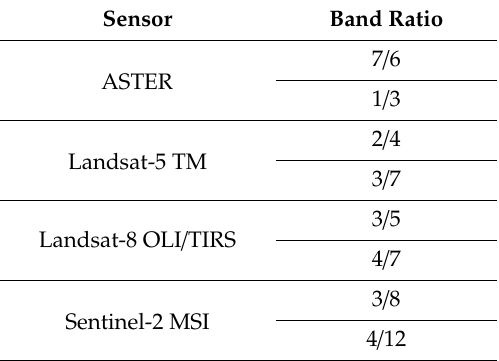
Table A2. Band ratios proposed to identify Li pegmatites